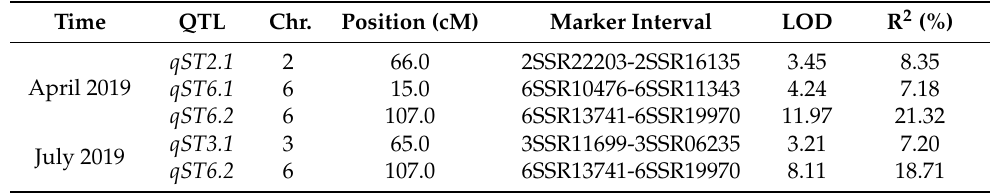
Table 2. Quantitative trait loci (QTL) controlling salt tolerance and their effect on cucumber seed- lings.